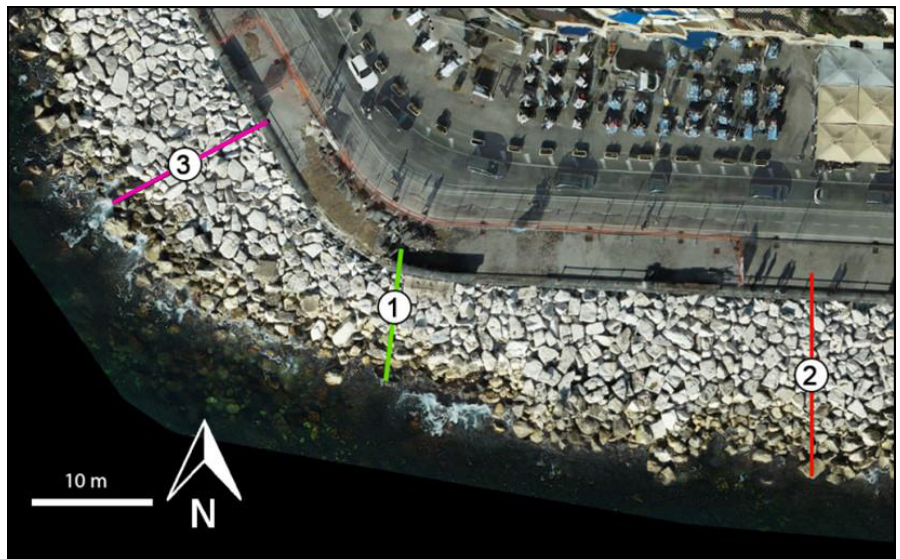
Figure 22. Reduction in width of the seawall, with a maximum in correspondence of the bend of Via Partenope Street (Section 1). The three section profiles are shown in Figure